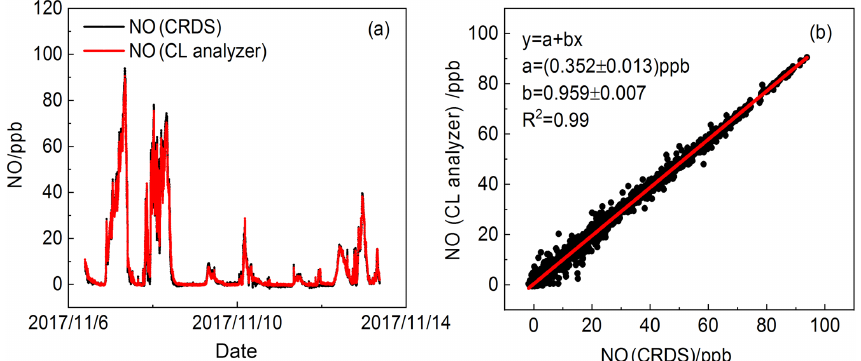
Figure 9. (a) Time series of NO by dual-CRDS instrument and CL analyser. (b) A correlation between two instruments is shown and data for correlation analysis are averaged in 1min.